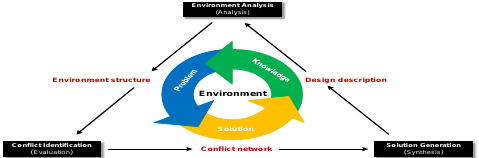
Figure 2 . Environment-based design (EBD) (Yang et al., 2021).